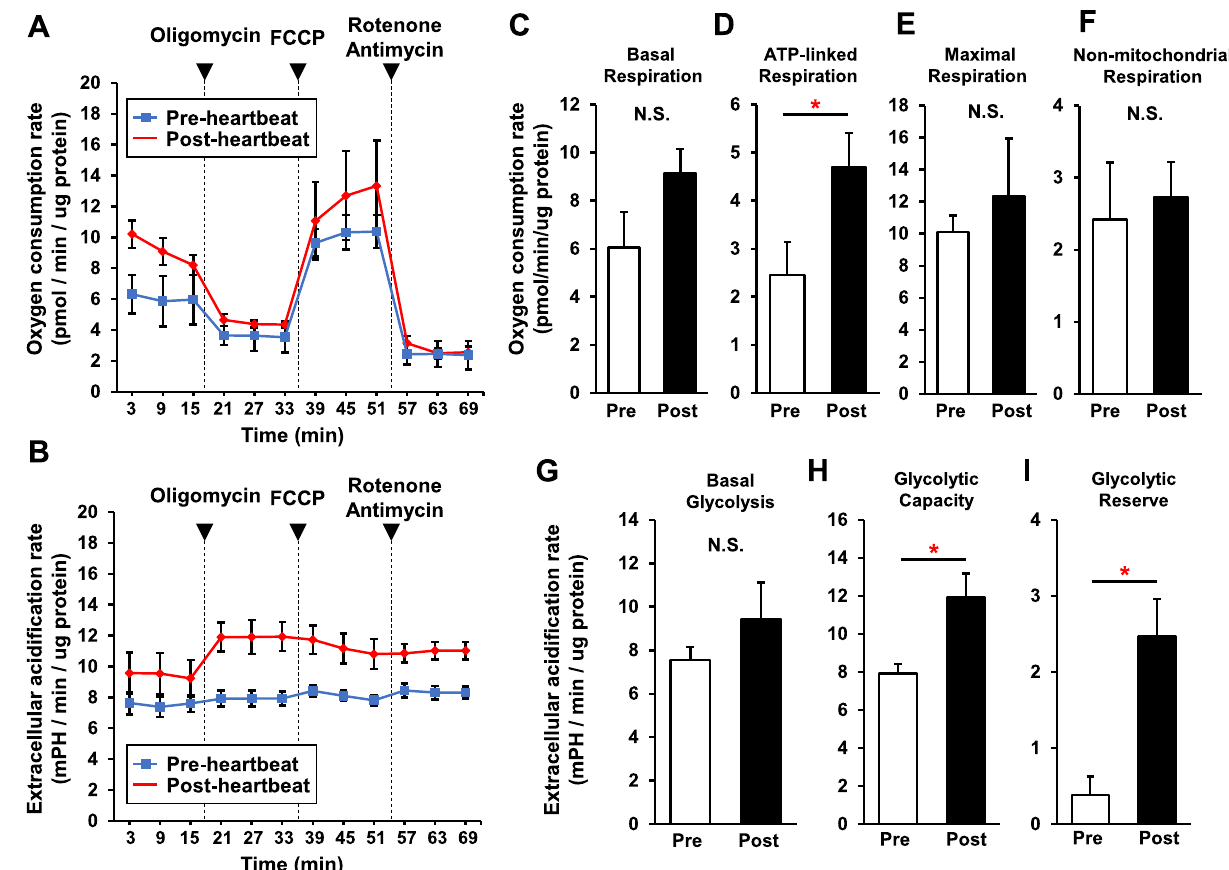
Figure 3. Increased glycolytic capacity and ATP synthesis-linked mitochondrial respiration in the heart primordium after heartbeat initiation. Analysis of OCR and ECAR was carried out using a Seahorse XFe96 Bioanalyzer to assess mitochondrial respiration and glycolysis. ( A , B ) OCR ( A ) and ECAR ( B ) were measured in isolated cells from the heart primordium in the pre- and post-heartbeat groups (N = 5) with subsequent addition of oligomycin (complex V inhibitor), FCCP (a protonophore), and rotenone (complex I inhibitor)/antimycin A (complex III inhibitor). ( C ) Mitochondrial bioenergetic parameters calculated from the results for OCR in the pre- and post-heartbeat groups. ( D ) Glycolytic parameters calculated from the results for ECAR in the pre- and post-heartbeat groups. *p < 0.05 with Welch’s t-test. N.S.: not